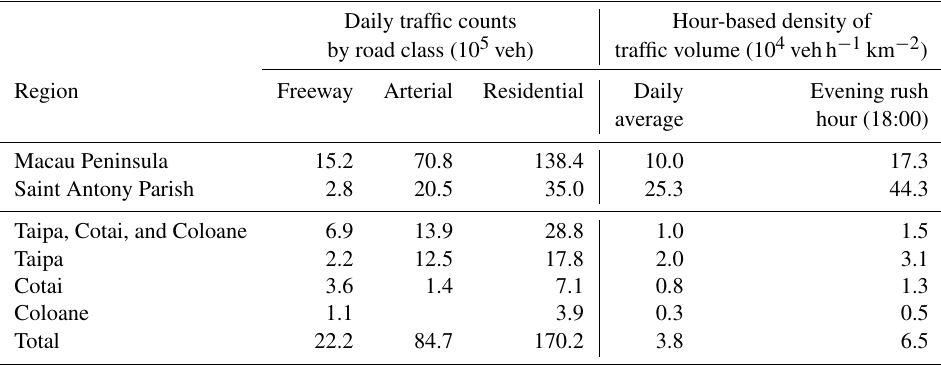
Table 3. Spatially explicit estimation of traffic counts in